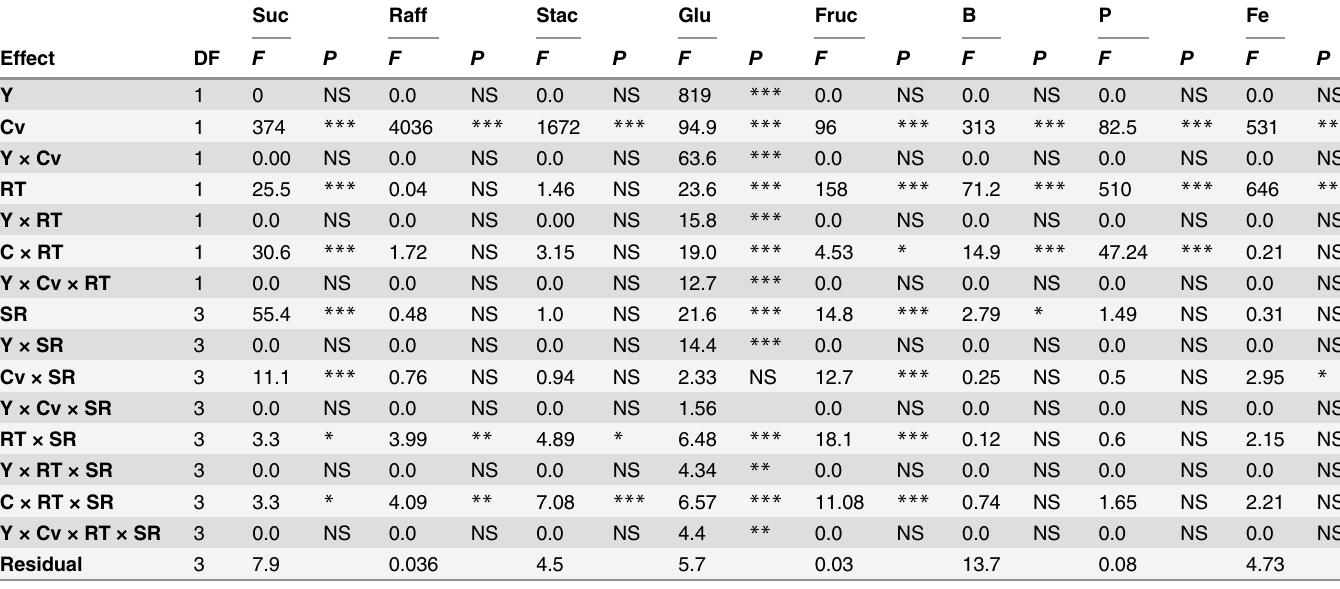
Table 3. Analysis of variance ( F and P values) of the effects of year (Y), cultivar (Cv), row-type (RT, either single- or twin-row), and seeding rate (SR) on the concentrations of seed sugars (sucrose, raffinose, stachyose, glucose, and fructose, mg g -1 ) and boron (B, mg kg -1 ), phosphorus (P, g kg -1 ), and iron (Fe, mg kg -1 ) in soybean cultivars 94M80 and GP 533 in Sharkey clay soil.